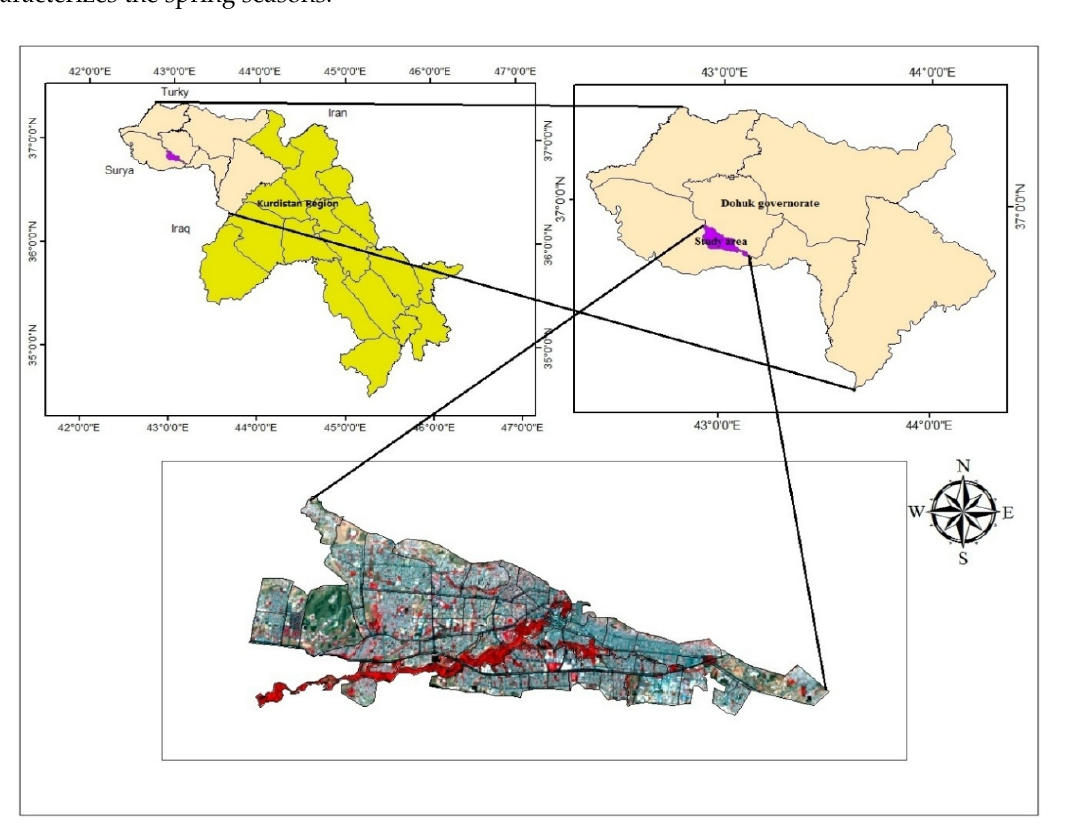
Figure 1. Illustration of the location of the study area, Duhok City.